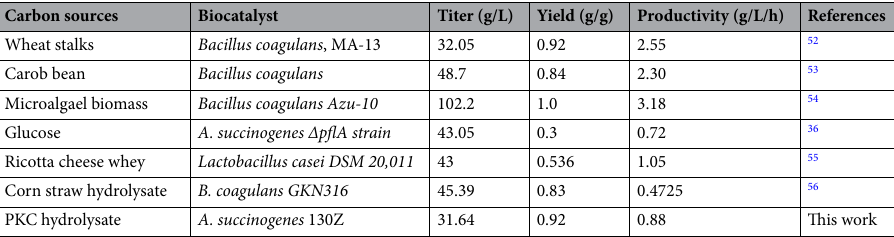
Table 4. Different carbon sources with the titer, yield, and productivity of lactic acid fermentation using different biocatalysts.